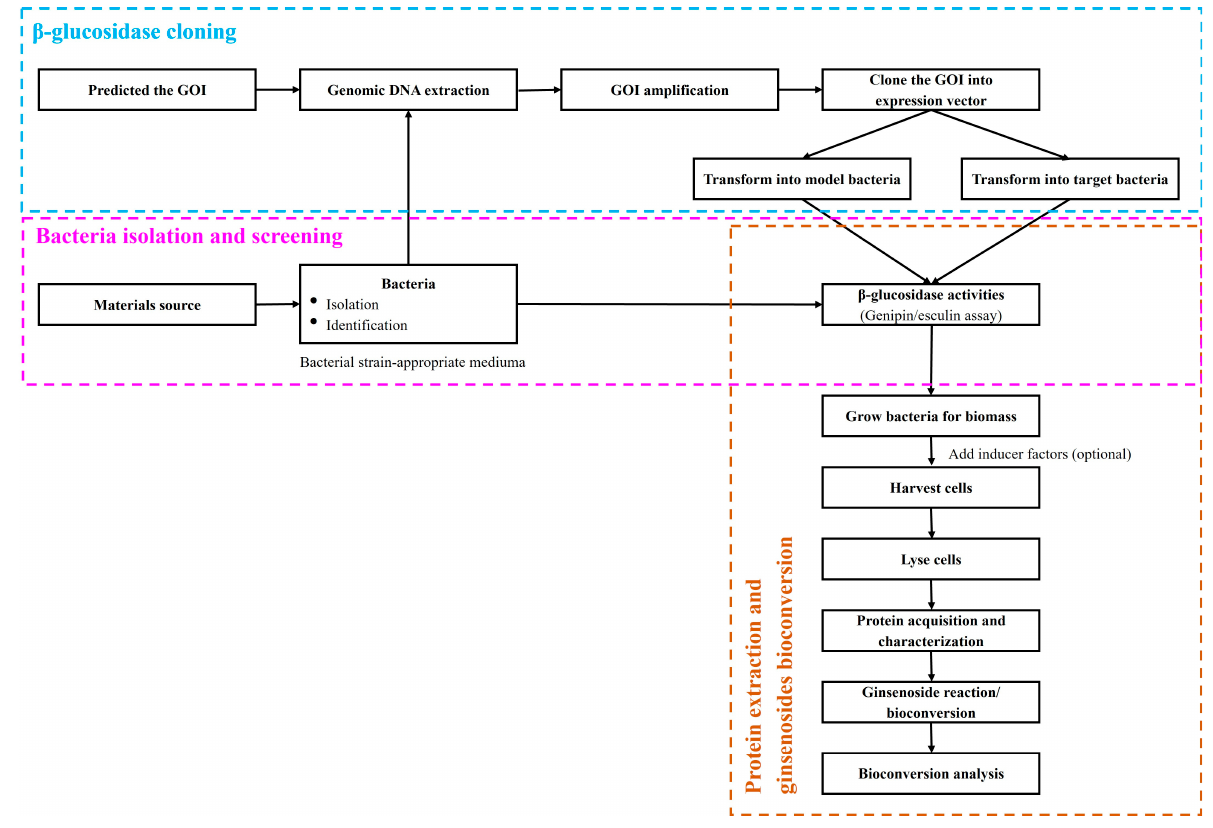
Figure 3. General process of ginsenoside conversion by microorganisms and recombinant enzymes. The procedure for isolating and screening bacteria and the method for cloning the recombinant enzymes are described in the pink and blue boxes, respectively. The steps involved in protein extraction and ginsenoside bioconversion are outlined in the brown box. GOI: Gene of interest. Ginseng plants have a long lifespan, ranging from four to six years, and the quality of their phytochemical compounds is low. Therefore, using ginseng as the primary material for large-scale industrial production is time-consuming and costly. Alternately,